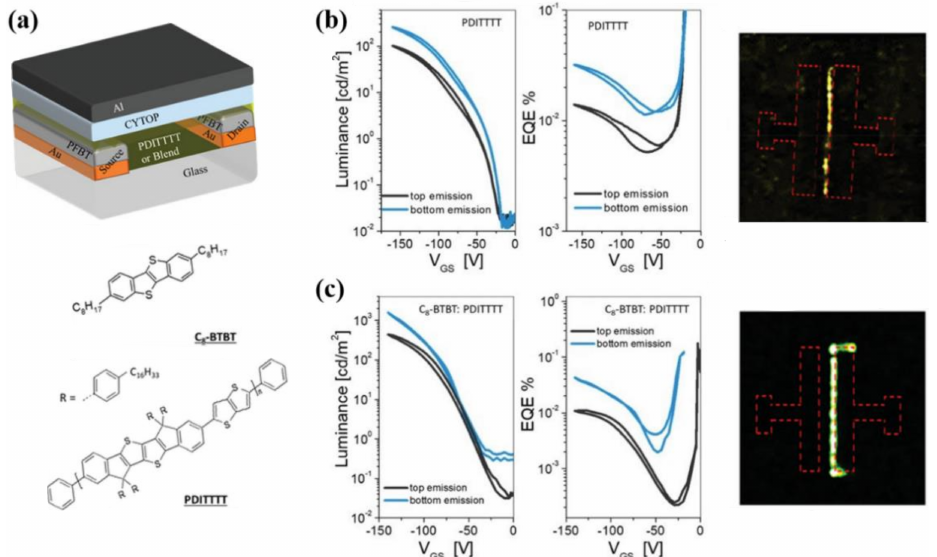
Figure 6. Blended single layer organic light emitting transistor. ( a ) Top gate–bottom contacts OLET based on a single layer blend based on PDITTTT (polymer) and C8–BTBT (small molecule). Luminance and EQE voltage dependence for ( b ) PDITTTT polymer and ( c ) C8-BTBT:PDITTTT blend with corresponding device optical images in ON state. Reproduced from [32], © (2019) John Wiley and